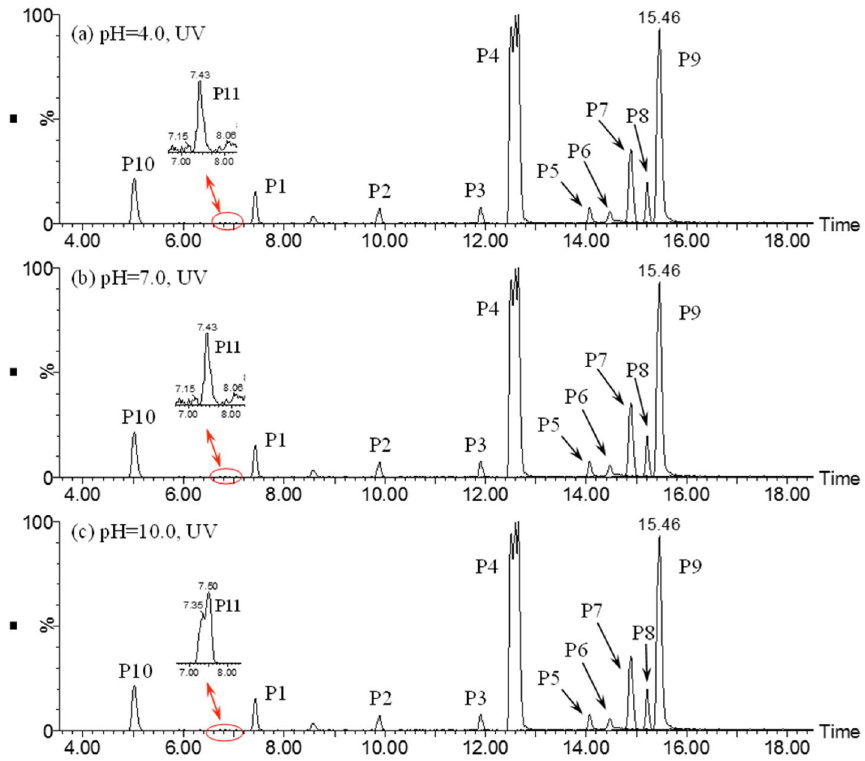
Figure 2. The extracted ion chromatograms (EICs) of ATZ solution after 90 min irradiation in UV process: ( a ) pH = 4.0; ( b ) pH = 7.0; (c) pH =